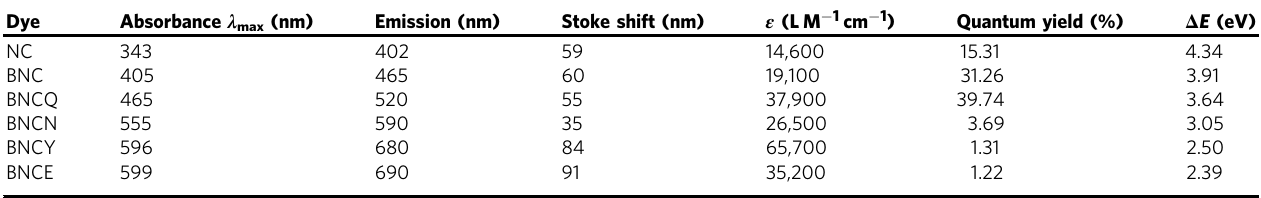
The quantum yields were determined using cresol purple as reference ( Φ f = 0.58 in